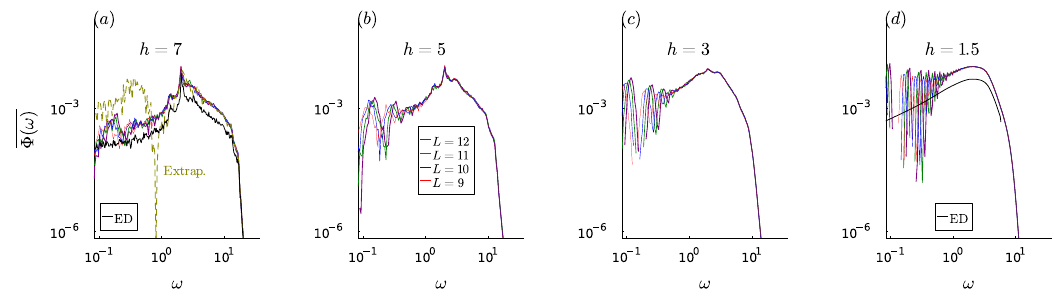
Figure 6: The low-frequency part of the disorder-averaged spectral function Φ ( ω ) = 1000, several system sizes L and disorder strengths (a) for the Krylov order n max h = 7 (b) h = 5 (c) h = 3 (d) h = 1.5. In (a) and (d), we benchmark the results with the spectral function obtained from exact diagonalization (ED) at the system size L = 11. (Note that we impose a cutoff frequency in the ED result for the ease of computation.) In (a), we also plot the spectral function Φ ( ω ) obtained from the extrapolated b n